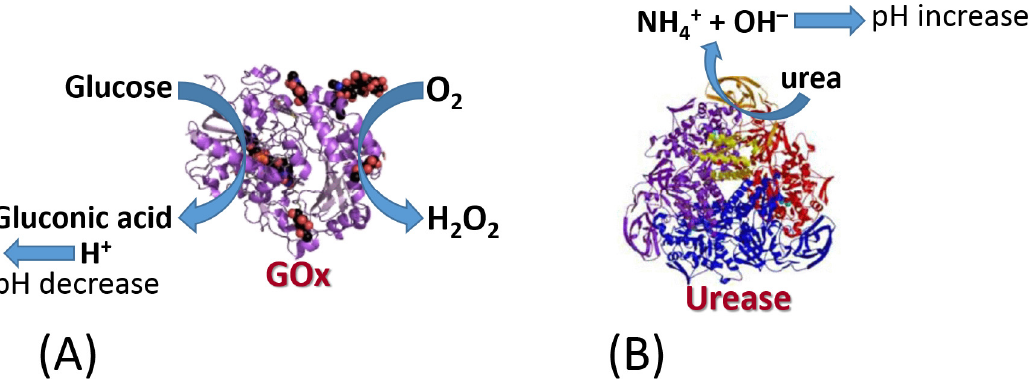
Figure 25. Examples of the pH decrease ( A ) and increase ( B ) produced by enzyme reactions. Nota ‐ bly, in practical applications, the enzymes should be immobilized onto a pH ‐ sensitive transducer